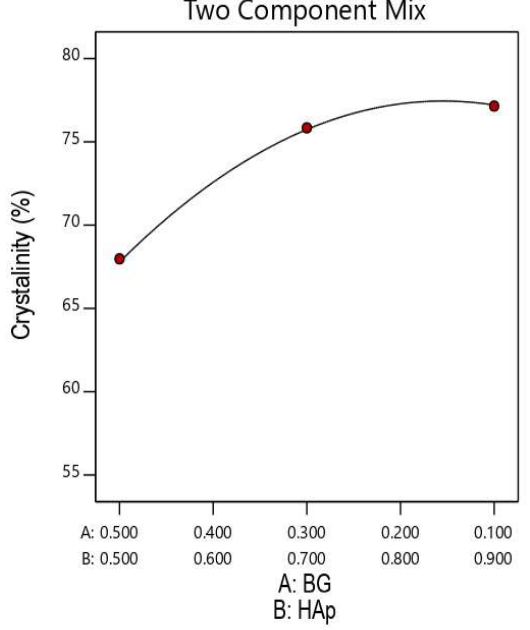
Figure 8. Effect of HAp/BG composite mixture components on HAp crystallinity.